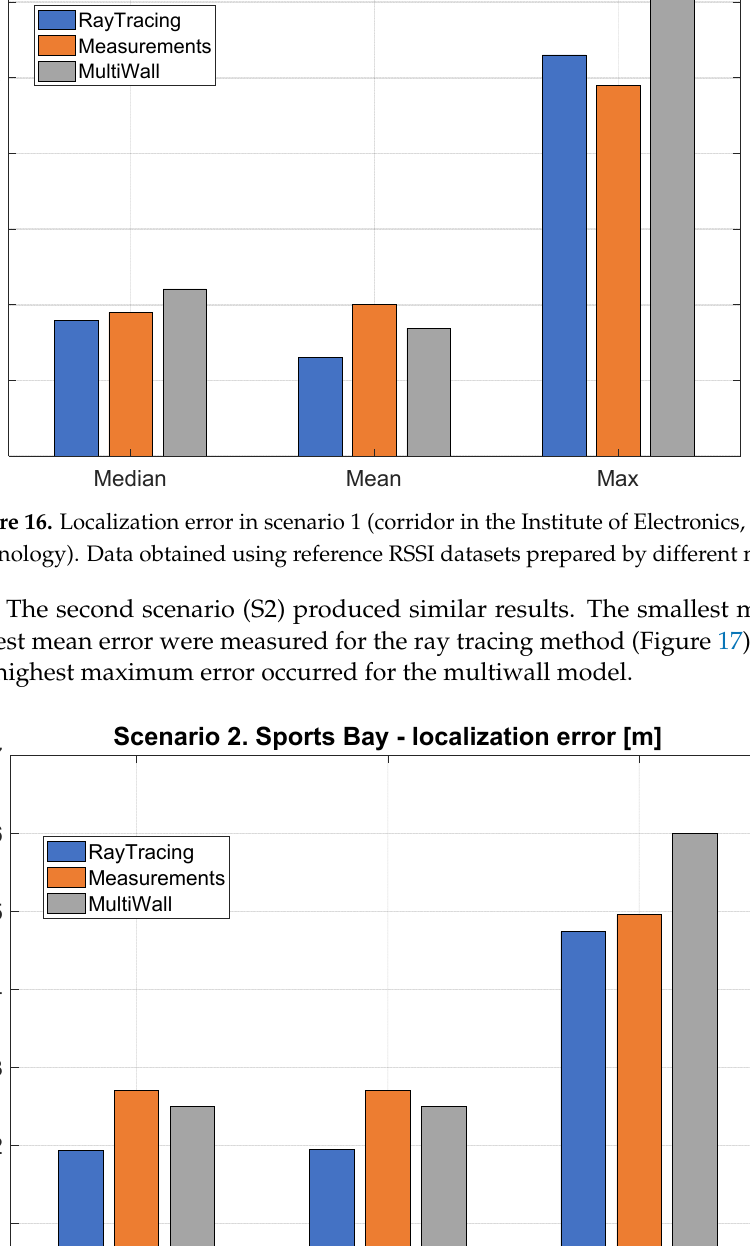
using interpolated measurement data (Figure 18). The mean error and the median error occurred for the multiwall occurred for the multiwall method.